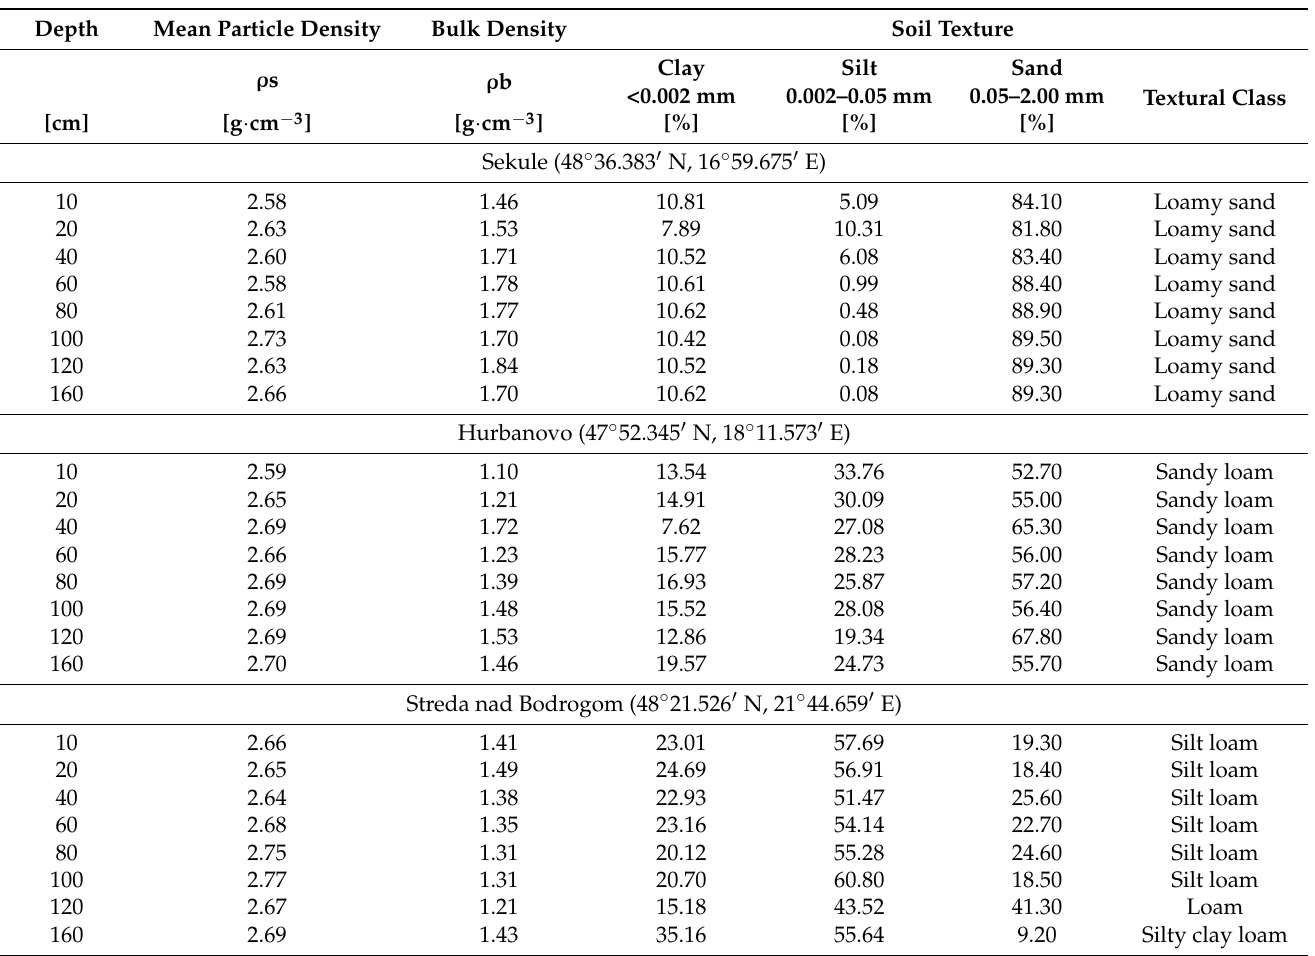
Table 2. Examples of grain size analysis at the Sekule, Hurbanovo, and Streda above Bodrog IH SAS